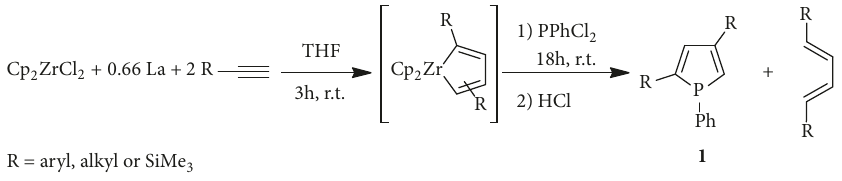
Scheme 1: Selective formation of 2,4-disubstituted phospholes 1